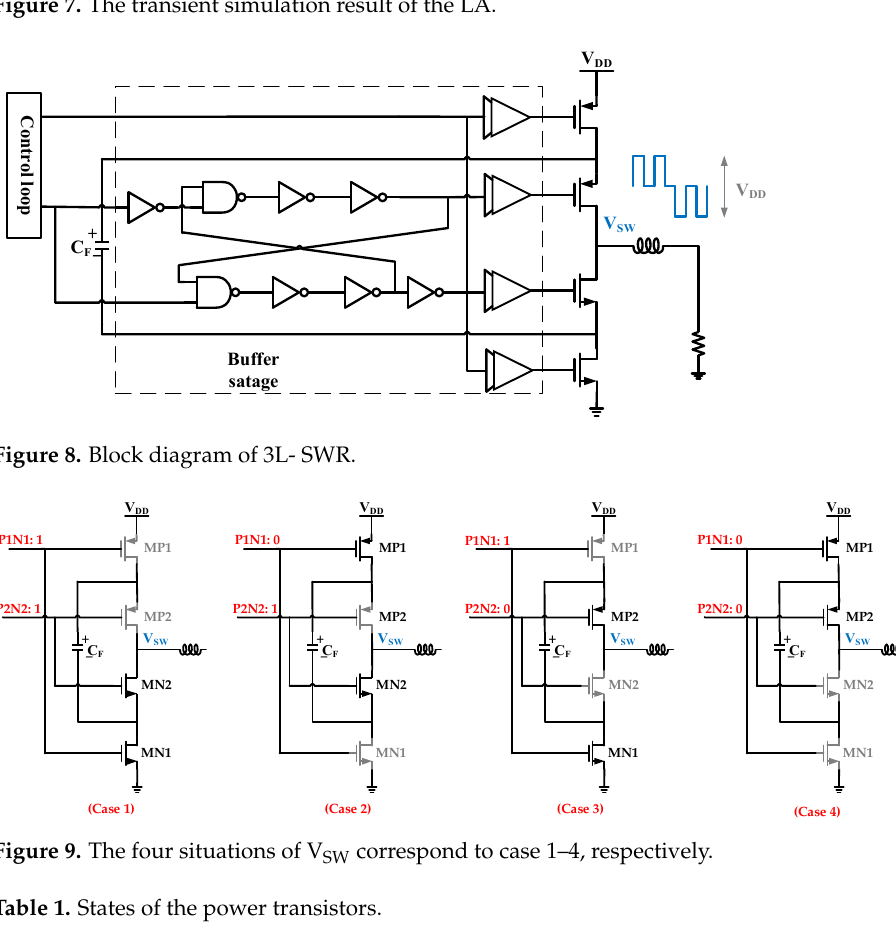
Figure 7. The transient simulation result of the LA.